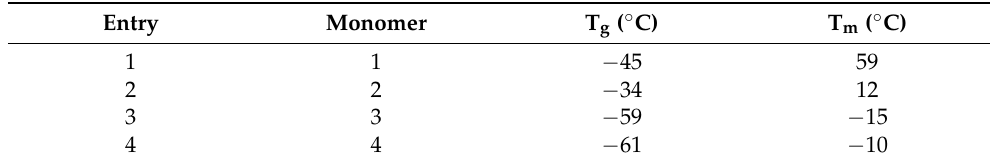
Table 1. Glass transition temperatures (T g ) and peak melting temperatures (T m ) of the cutin monomer and derivatives ( 1 – 4